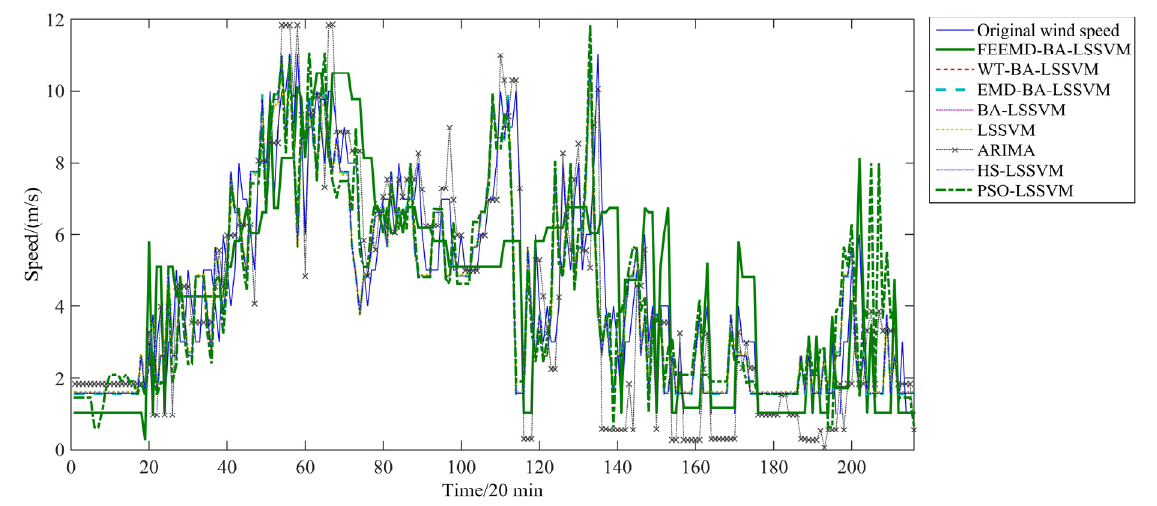
Figure 14. Forecasting results without temperature as